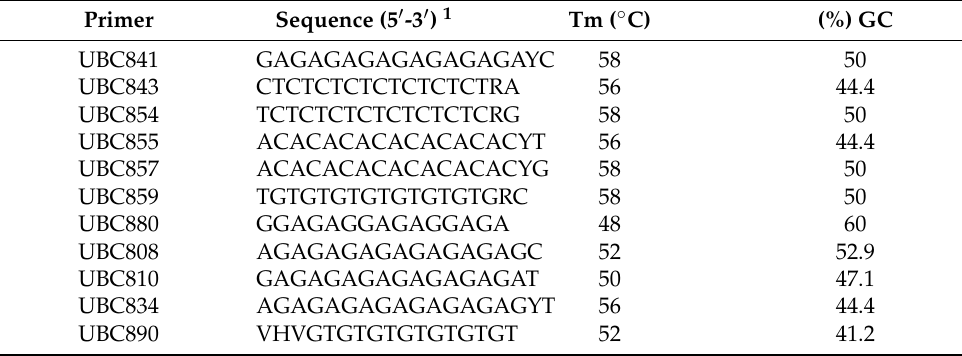
Table 2. ISSR primer sequence used in the PCR analysis.